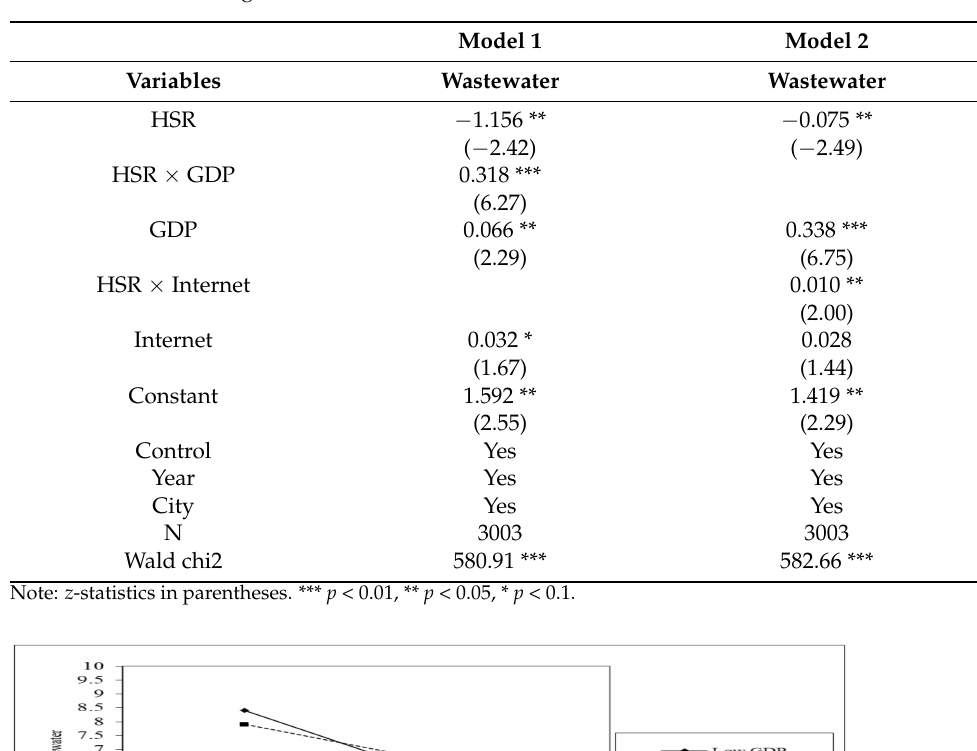
Table 5. The moderating effect.